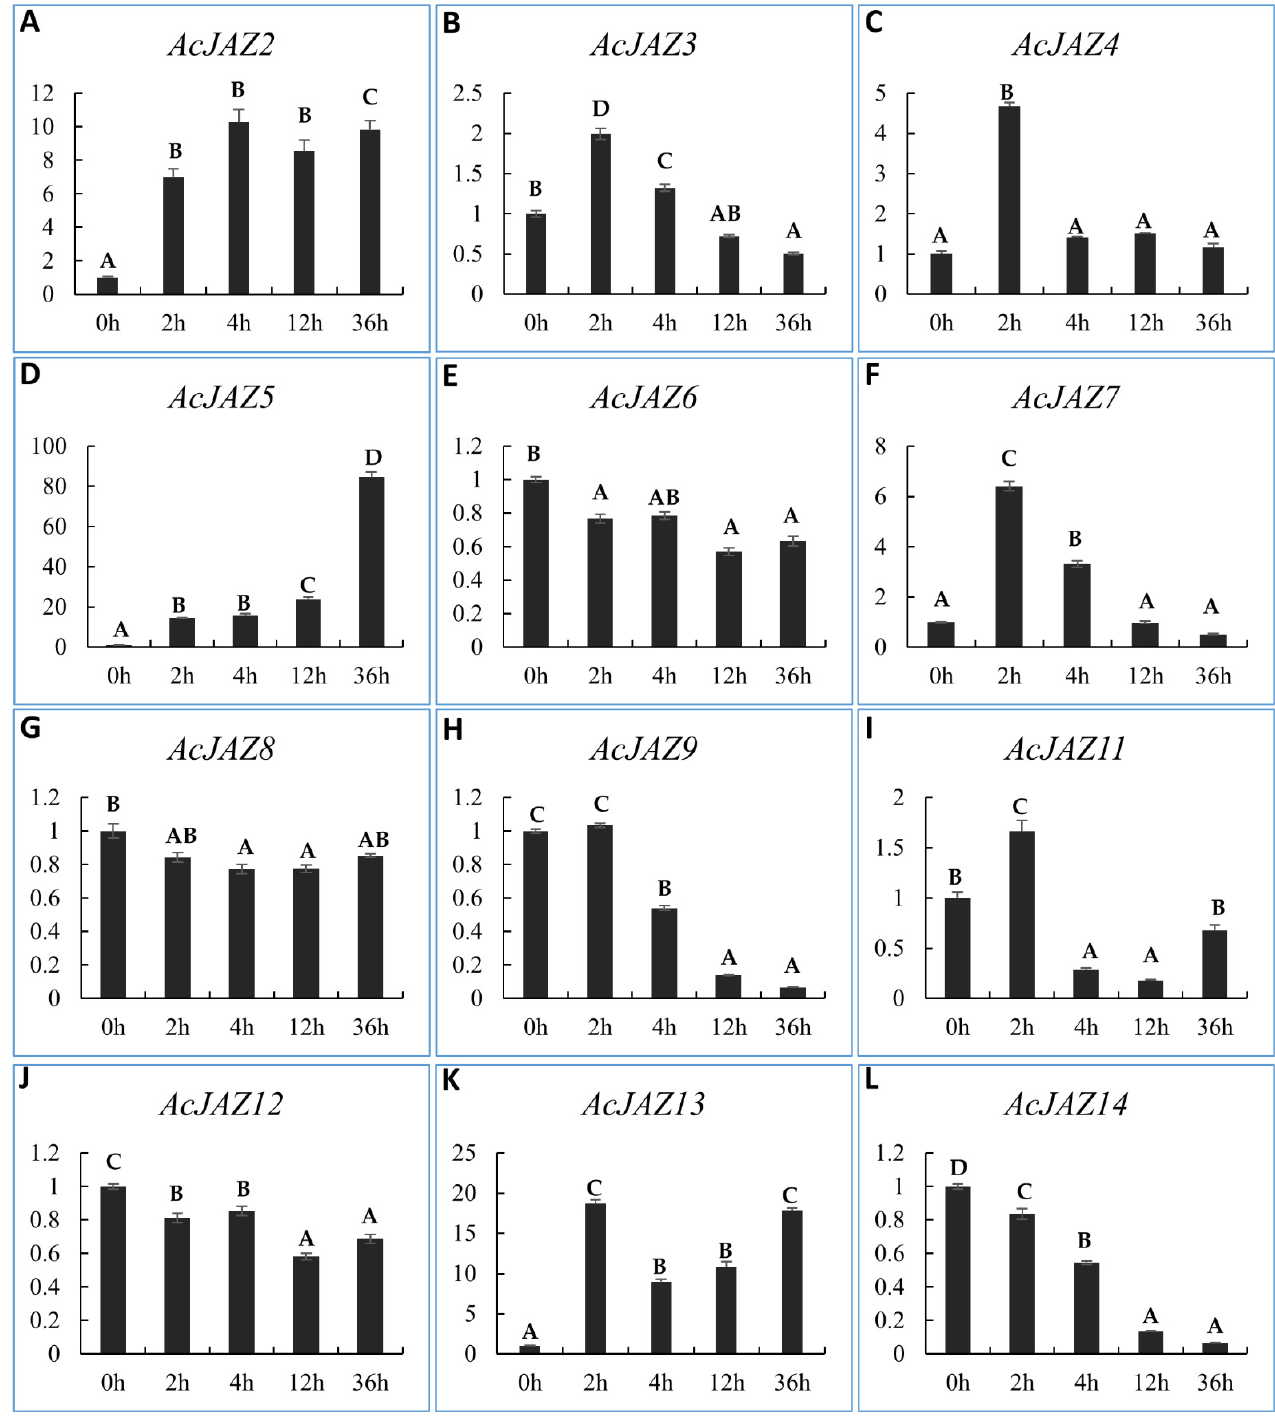
Figure 5. The expression analyses of AcJAZ genes under MeJA treatment. The expressions of most AcJAZ genes except AcJAZ1 and AcJAZ10 were analyzed by RT-qPCR ( A – L ). The leaves and roots from one-month-old pineapple seedlings treated with MeJA for 0 h, 2 h, 4 h, 12 h, and 36 h were used to prepare RNA samples. AcPP2A gene was used as a reference for RT-qPCR normalization. The upper case letters A, B, C, D indicated the significant difference ( p < 0.01) among the samples of different time points. Any of the two samples containing the same letter belong to the same group, which would be regarded as not having a significant difference.